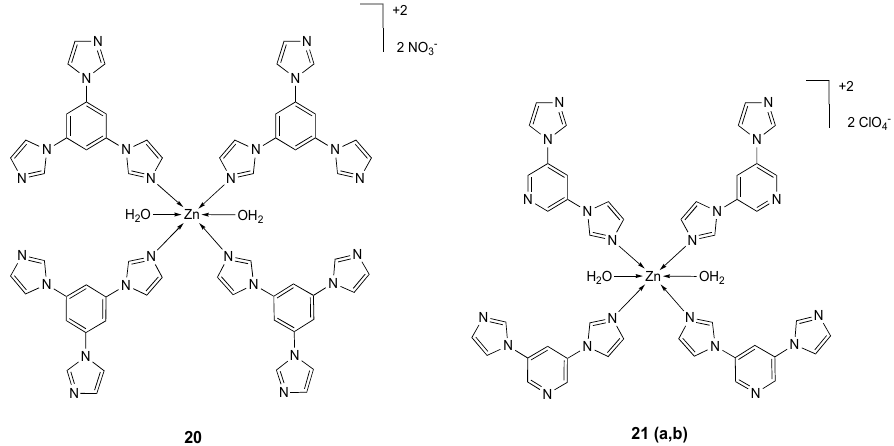
Figure 11. Structure of the zinc complexes 20 and 21 . Table 5. IC 50 values (µM) for zinc complexes 20 , 21a , b and reference cisplatin against HeLa and KB tumor cell lines after an incubation time of 24, 48 or 72 h.